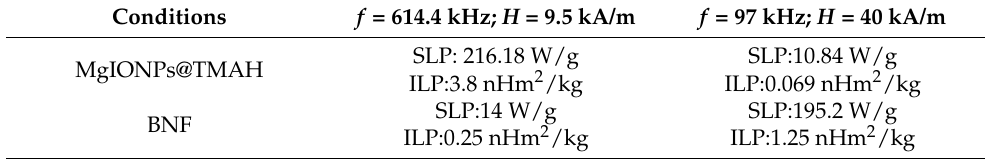
Table 1. Comparisons of the SLP and ILP of the prepared NPs and the commercial NPs (BNF).